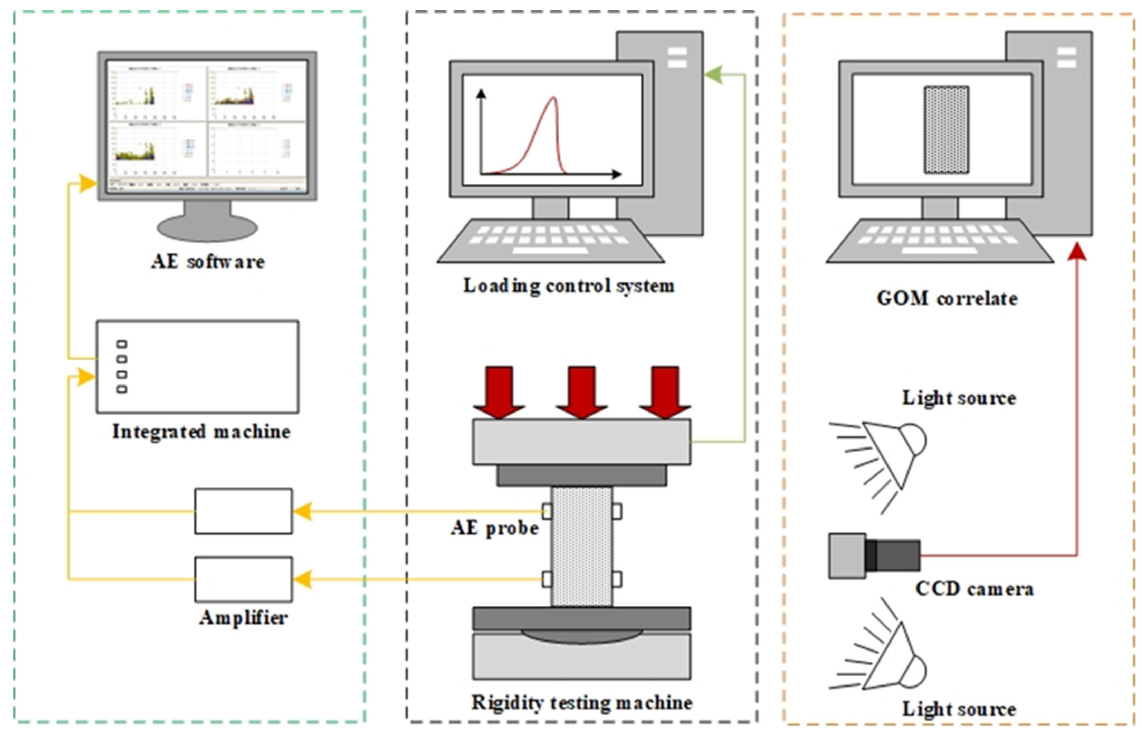
Figure 2. Schematic diagram of the loading system, the DIC system, and the AE system.